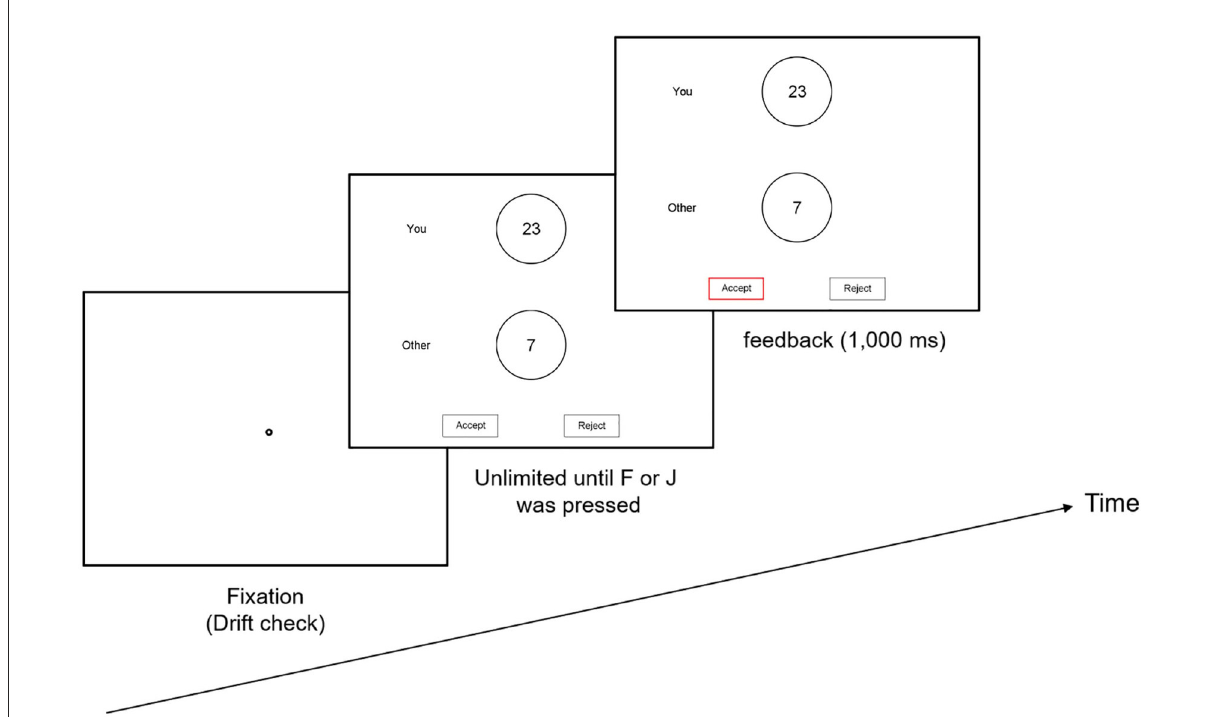
FIGURE1 Trial procedure and timing in the experiment. Each trial began with a fixation in the middle of the screen. After each response, a 1,000-ms intertrial interval with a feedback screen was presented before the next trial